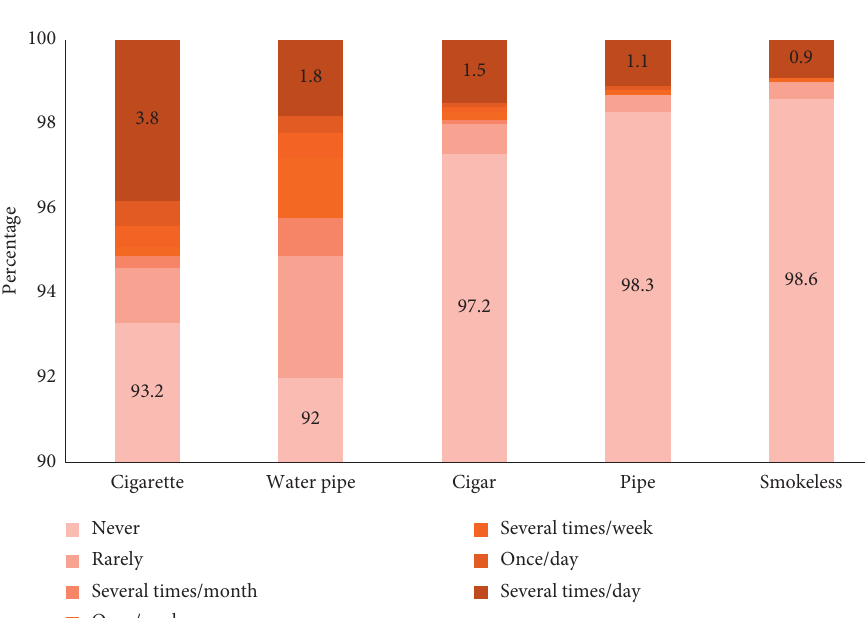
Figure 2: Frequency of using tobacco